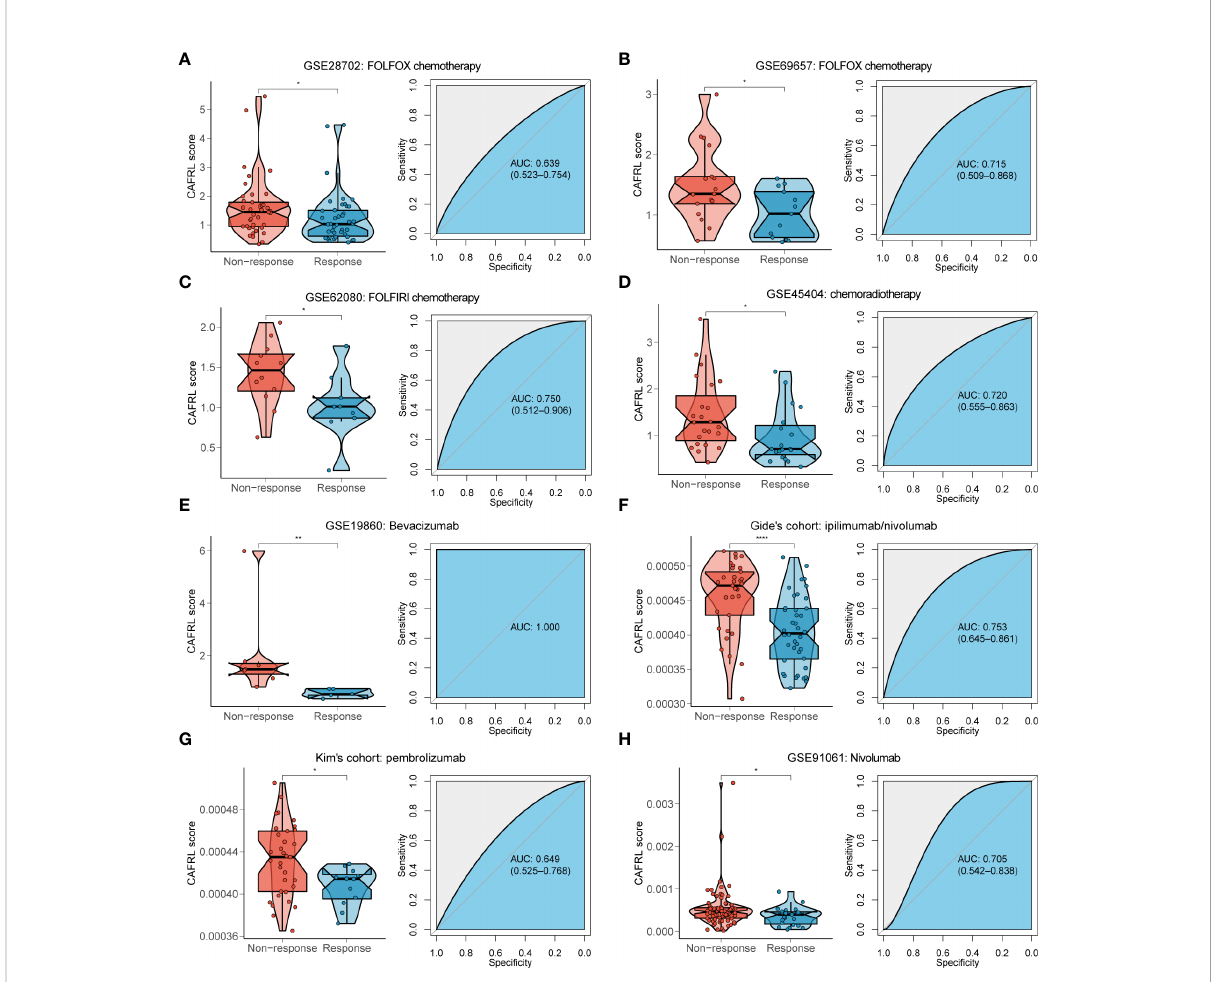
FIGURE 4 CAFDL signature can effectively predict the response to mainstay treatments of CRC. (A – E) Non-responders to FOLFOX (A, B) and FOLFIRI (C) chemotherapy, chemoradiotherapy (D) , and bevacizumab targeted therapy (E) had signi fi cantly higher CAFDL scores compared with responders (left panels). ROC curves demonstrate the predictive power of the CAFDL signature for response to these treatments (right panels). (F – H) Non-responders to ipilimumab/nivolumab (F) , pembrolizumab (G) , and nivolumab (H) had signi fi cantly higher CAFDL scores compared with responders (left panels). ROC curves demonstrate the predictive power of the CAFDL signature for response to these treatments (right panels). *P < 0.05, **P < 0.01, and ****P <